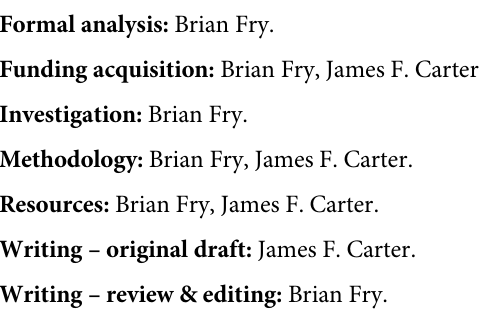
S3 Table. Tabular listing of replicate runs for individual samples. S4 Table. Tabular listing of 15AAmix reference material runs associated with individual samples. S5 Table. Tabular listing of CSIA data from Choy et al. (2010) used for comparison with this study. S6 Table. Tabular listing of Δ spacings (‰) for paired NEAAs in the 8 study samples to support heatmap in Fig